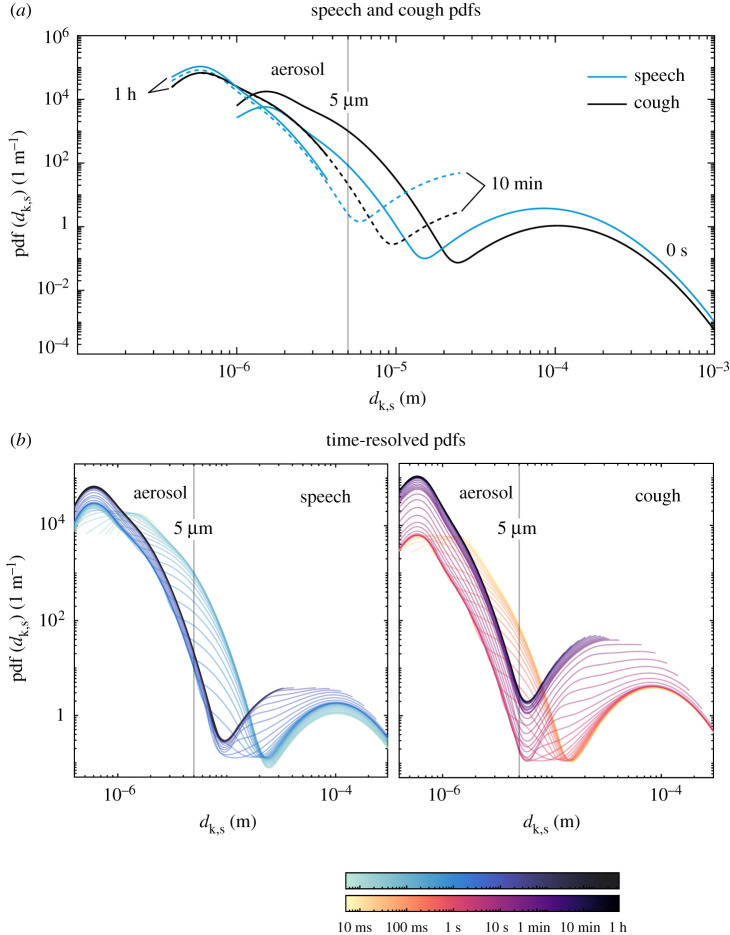
Evolution of the probability density function of droplet size from speaking and coughing, where (a) shows 0 s, 10 min and 1 h speech and cough pdfs, and (b) shows detailed time-resolved pdfs between 0–1 h coloured in a log scale—T = 20°C, RH = 60%. (Online version in colour.)